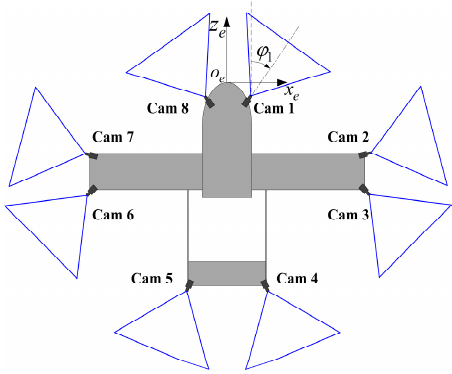
Figure 6. Eight cameras mounted on UAV.